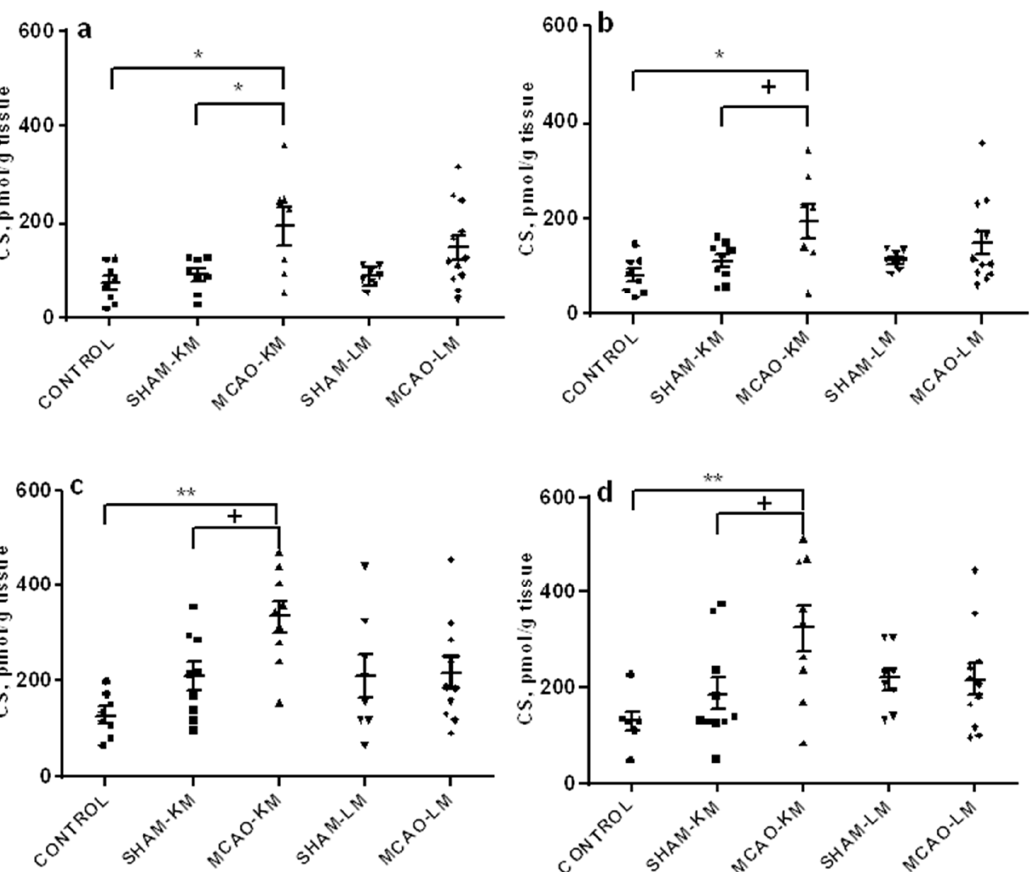
Figure 3. Corticosterone levels in the hippocampus ( a , b ) and FC ( c , d ) in MCAO-KM and MCAO-LM groups 3 days after surgery. ( a ) Ipsilateral hippocampus. ( b ) Contralateral hippocampus. ( c ) Ipsilateral FC. ( d ) Contralateral FC. ( a – d ) Corticosterone, pmol/g tissue.** p < 0.01, * p < 0.05, and + p < 0.1 compared to the respective sham-operated groups or control rats.